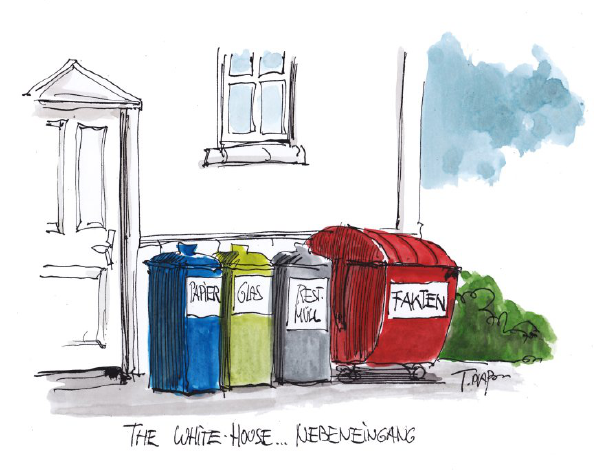
Figure 2 – «The White House …